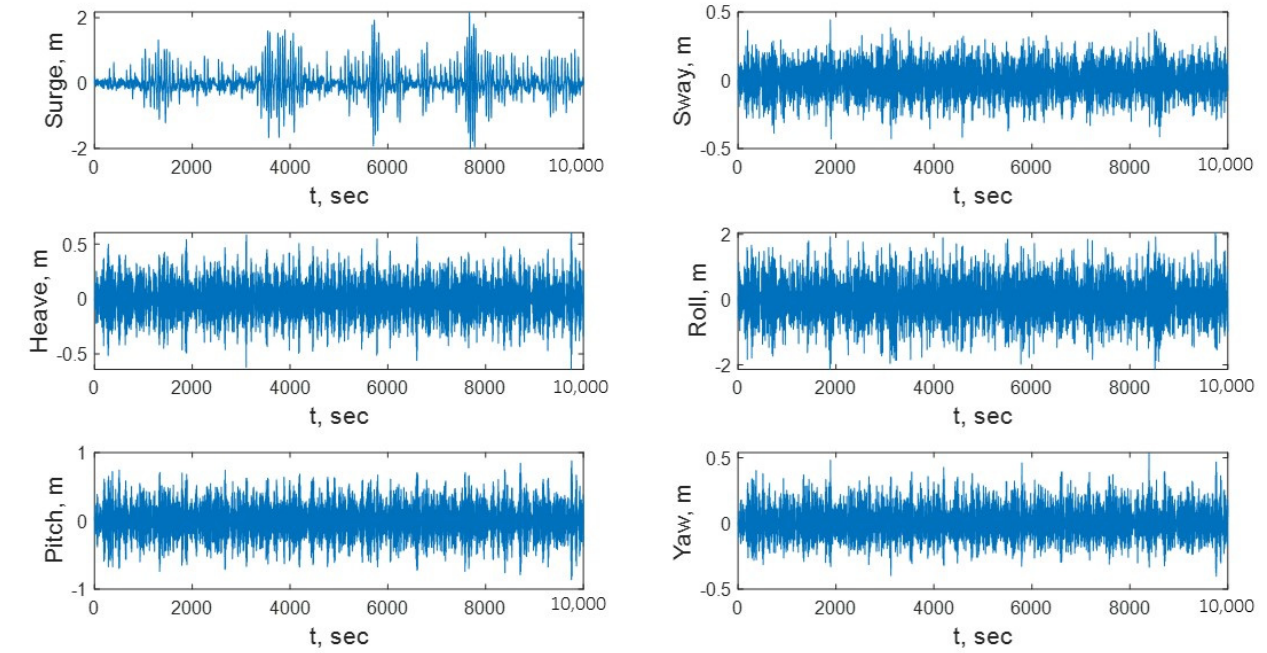
Figure A7. Load case s3 (H mo = 3 m)—wave frequency position. The surge and sway positions are relative to the position of the Delta, the other positions are absolute position of the ship.